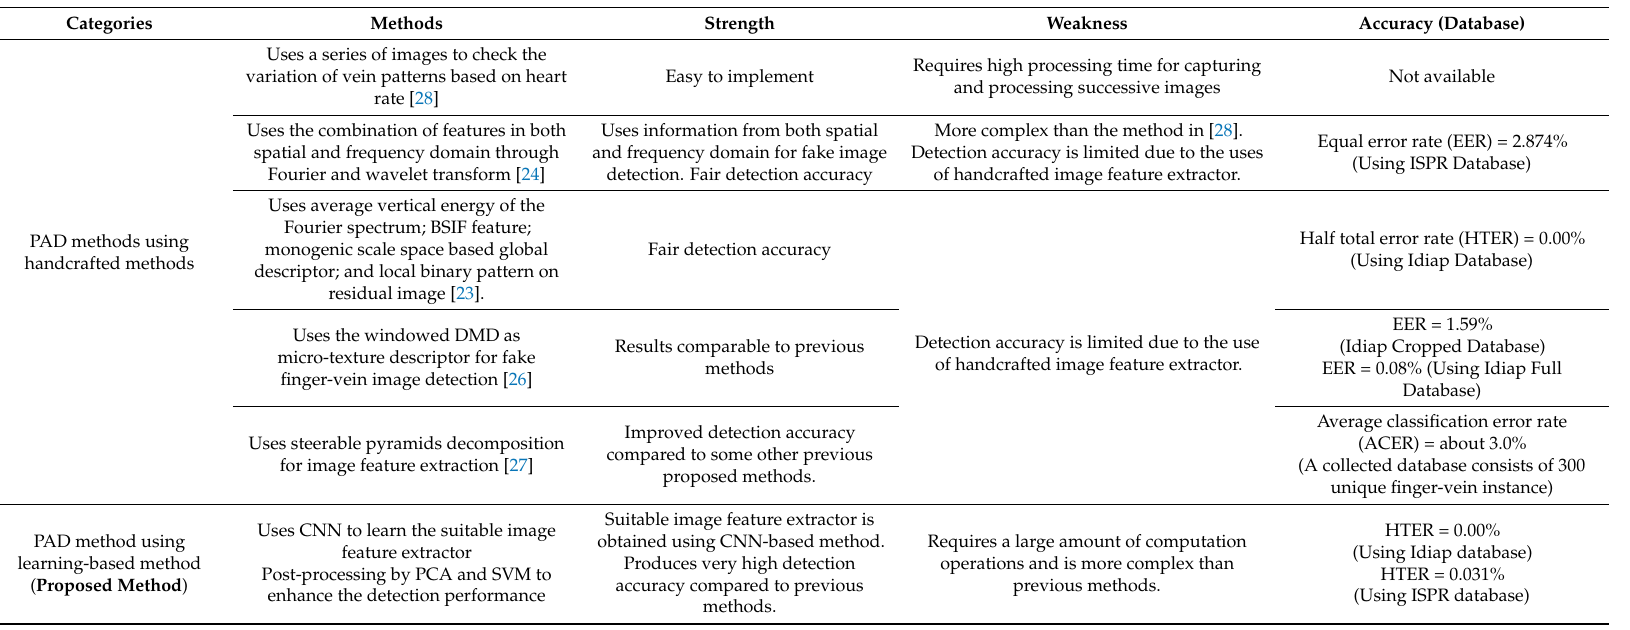
Table 1. A summary of previous studies on presentation attack detection (PAD) methods and our proposed